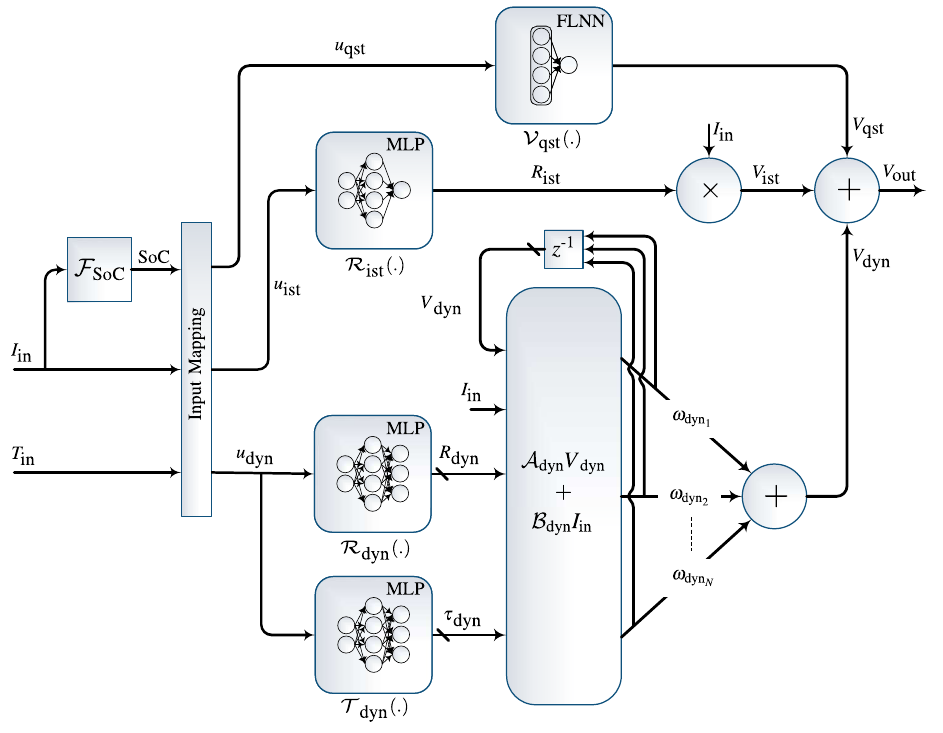
Figure 7. ENNC block